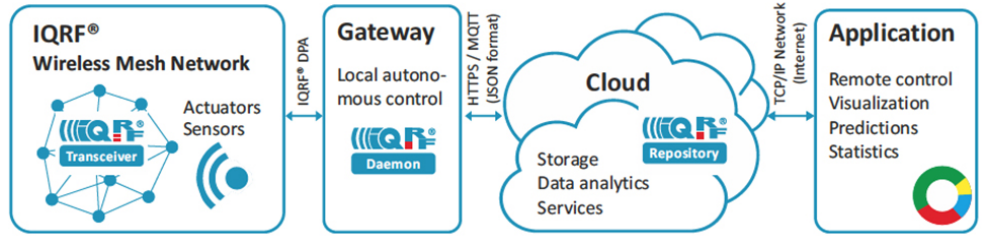
Figure 1. Typical IoT Application with IQRF network Design